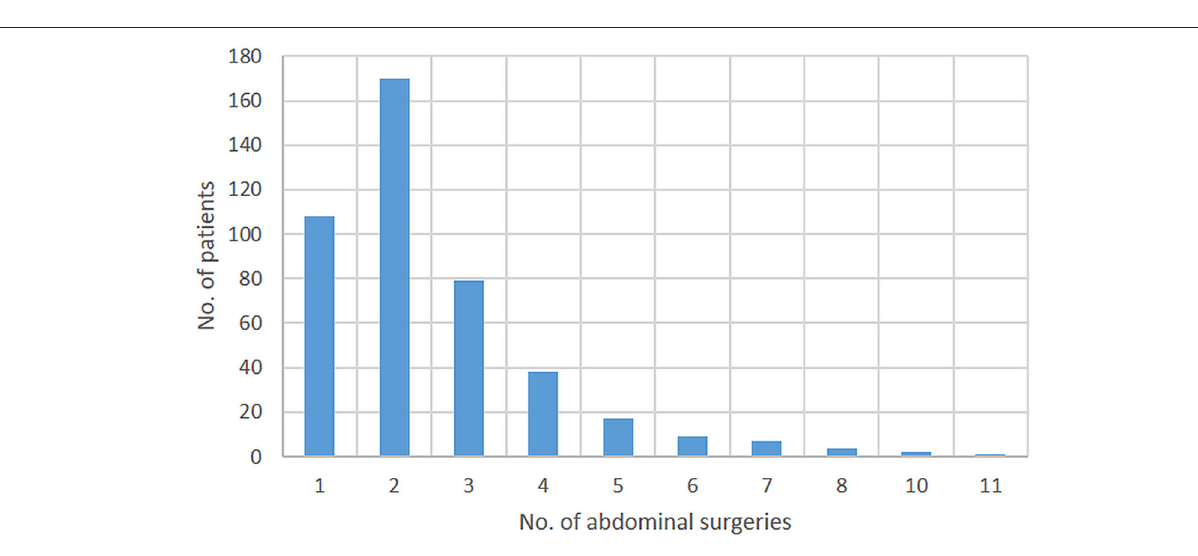
FIGURE 5 | Number of abdominal surgeries per